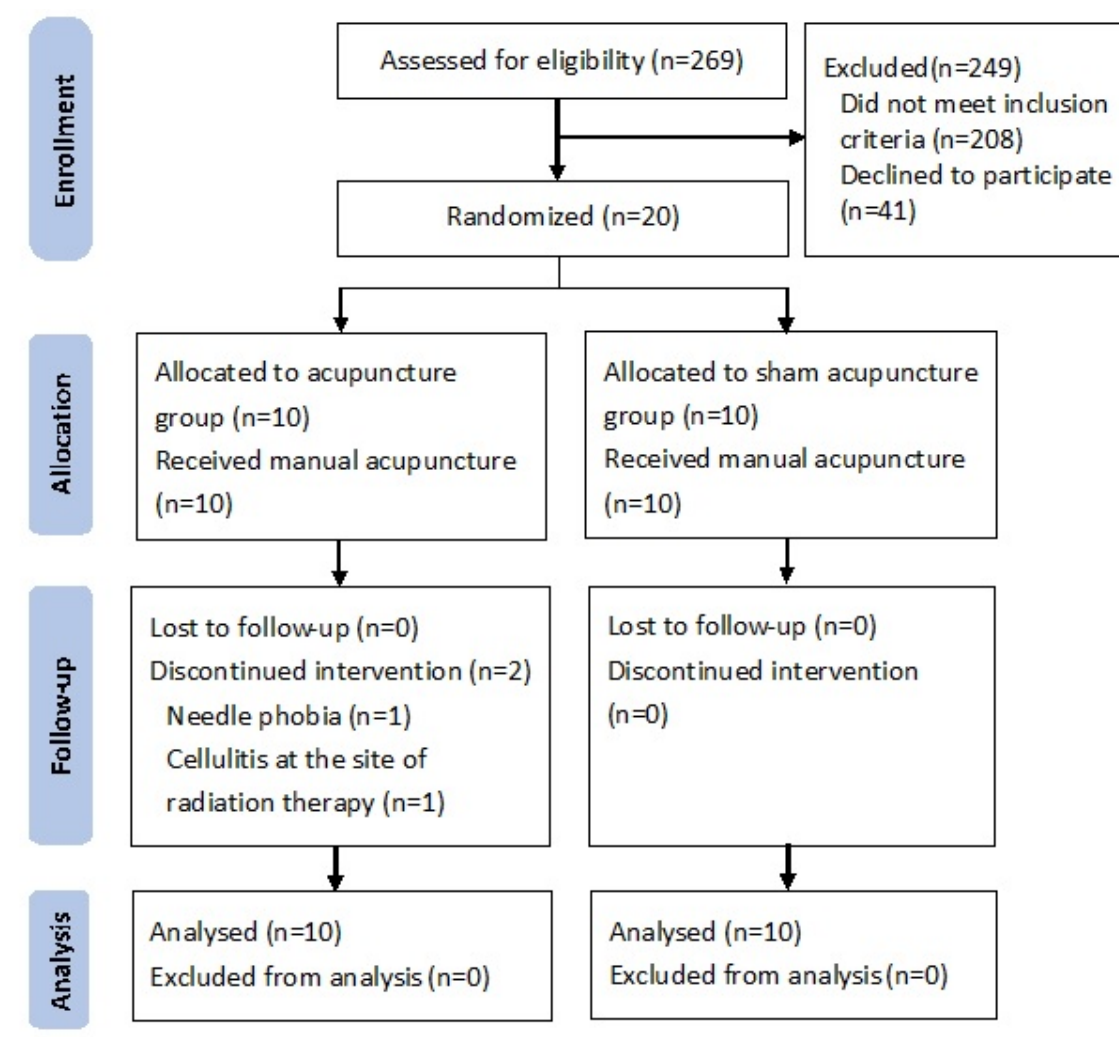
Figure 1. CONSORT flow chart.